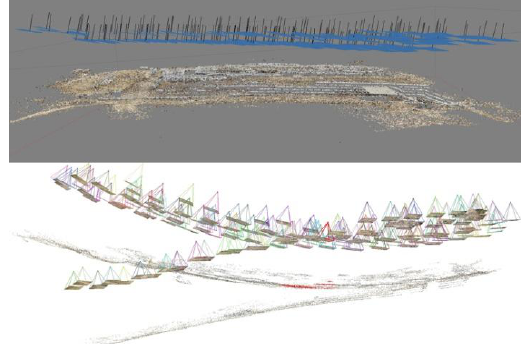
Figure 12: Alignment of open blocks (dataset of the temple). With PhotoScan the result is positive (above), while with VisualSFM is completely